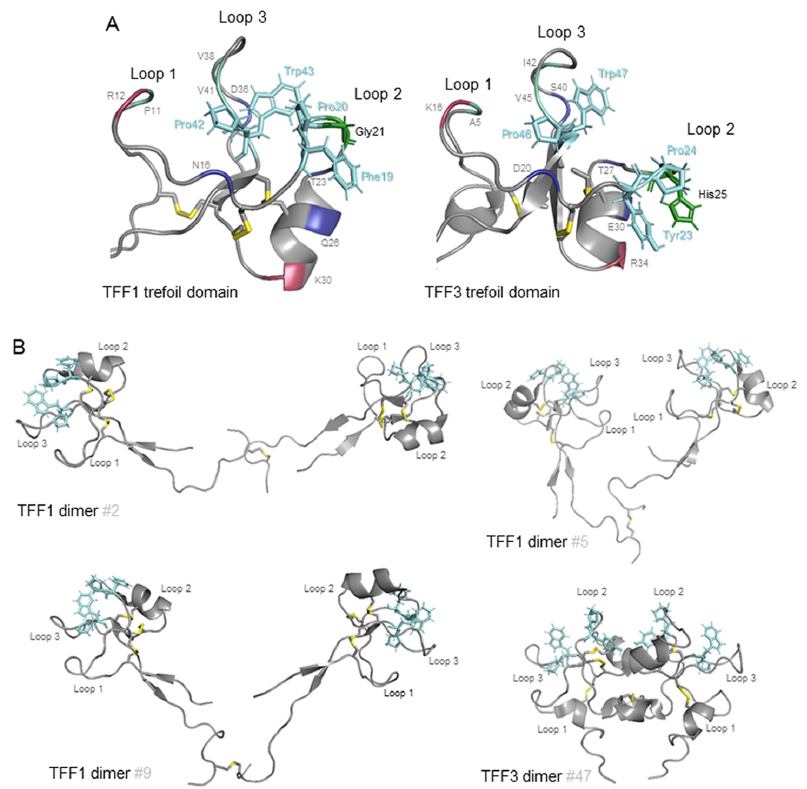
Figure 3. Hydrophobic surfaces of TFF1 and TFF3. Representations of the backbones of the TFF1 and TFF3 trefoil domains [57,60] ( A ) and TFF1 and TFF3 dimers [58,59] ( B ) are shown. The intramolecular and intermolecular disulphide bonds are shown and coloured yellow. The three fully conserved solvent accessible residues, Pro 20, Pro42 and Trp43 in TFF1, and one semi-conserved solvent accessible residue, Phe19 in TFF1, in loops 2 and 3 that form a continuous hydrophobic patch postulated to interact with a saccharide or aromatic amino acid sidechain between loops 2 and 3 are shown in stick representation and are coloured cyan ( A and B ). The backbones of the surface residues with conserved features that surround this patch are indicated in single letter code ( A ). Of these, the hydrophobic residues, Pro11 (P11), Val38 (V38) and Val41 (V41) in TFF1, are coloured pale green, the hydrogen bond donor, Arg12 (R12) is coloured raspberry red and the hydrogen bond acceptors, Asn16 (N16), Thr23 (T23), Gln26 (Q26) and Asp36 (D36) in TFF1, are coloured deep blue. Two other well-conserved residues on the edge of the hydrophobic patch are indicated. A positively charged residue, Lys30 (K30) in TFF1, is coloured raspberry red. The small Gly21 in TFF1 that would facilitate access to the hydrophobic cleft and the corresponding His25 residue of TFF3 proposed to impede access are shown in stick representation and are coloured forest green ( A ). Three of the solution NMR structures of the TFF1 dimer, #2, #5 and #9 and one of the TFF3 dimers (#47), are shown with the first monomer unit on the left-hand